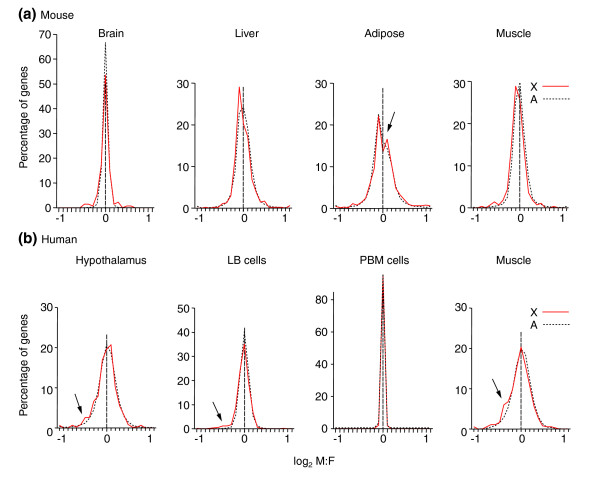
Comparison of male and female gene expression in mammals. In mouse (a) and humans (b), each tissue has a distinct distribution of M:F ratios, but in each case the distribution for X genes (red line) fits closely to the distribution for A genes (dotted black line). LB, lymphoblastoid cell lines. PBM cells, peripheral blood mononuclear cells. Arrows point to regions where the X and A curves diverge, or to the inflection point in the mouse adipose tissue curve.